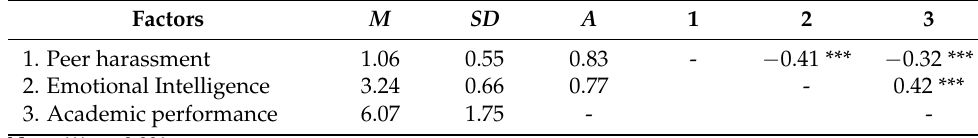
Table 1. Descriptive statistics, reliability analysis, and bivariate